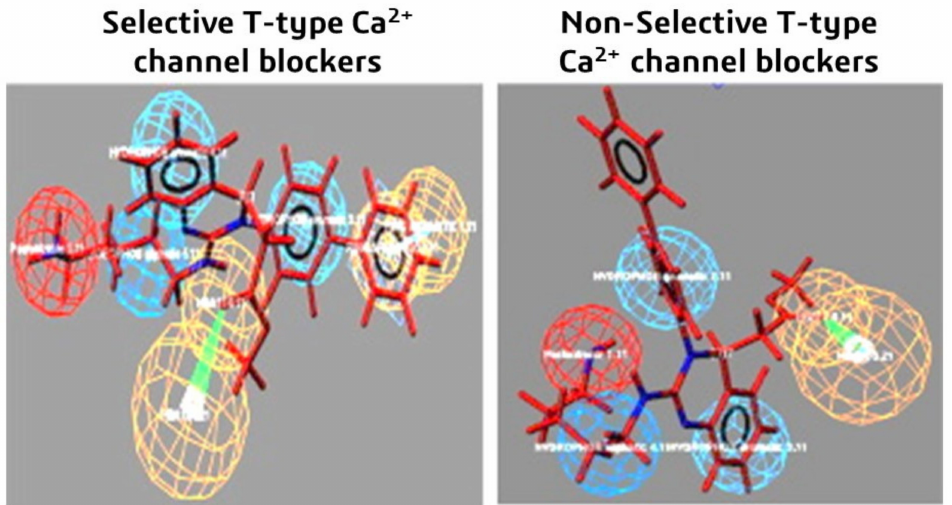
Figure 10. Predictive selective and non-selective 3D pharmacophore models used for the design and development of better and more safe T-type calcium channel blockers. Reprinted with permission from Ref. [108]. Copyright 2016,